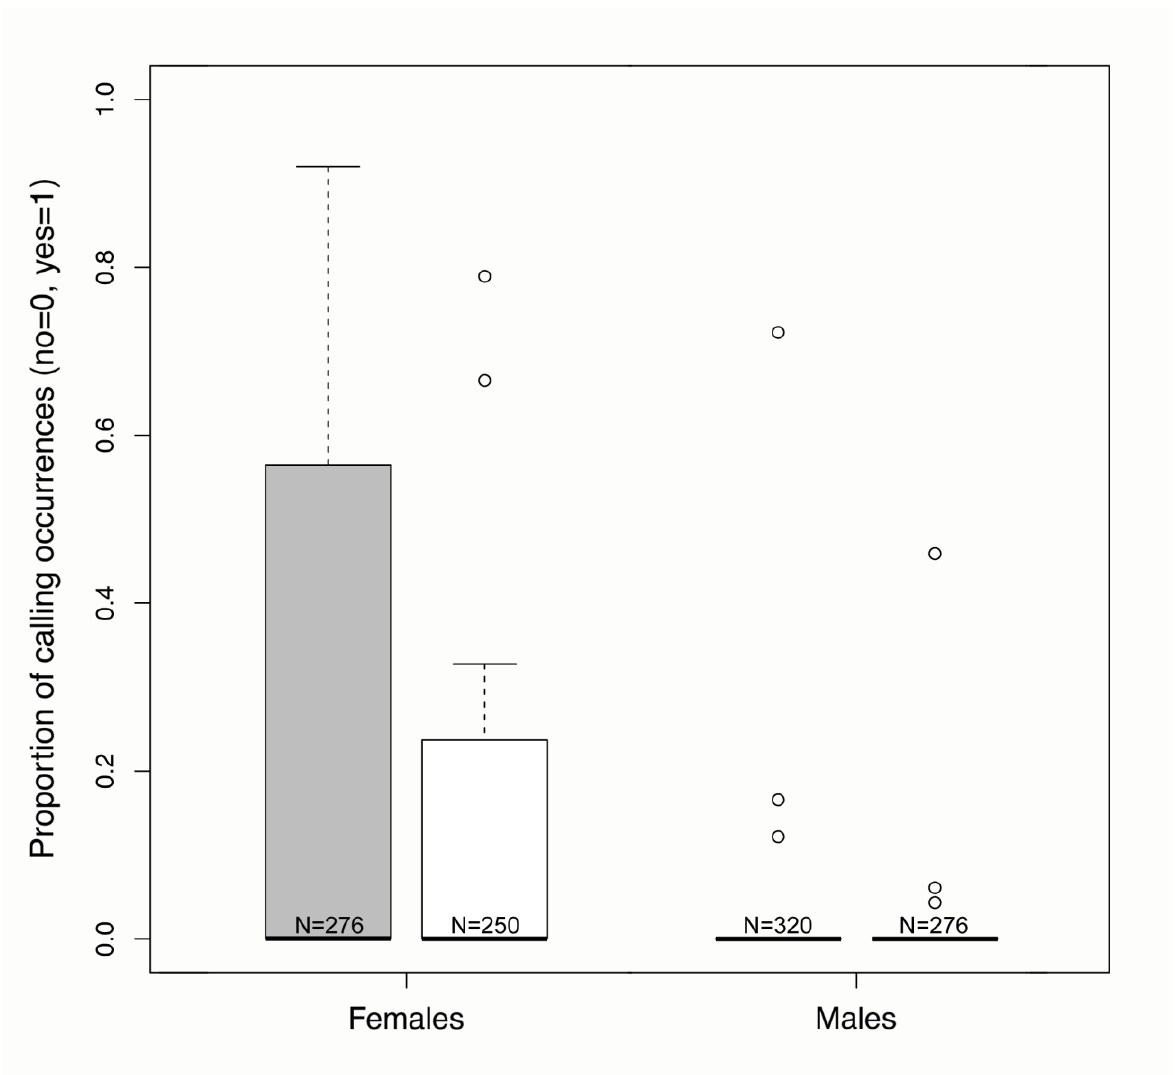
Figure 1 . Proportion of calling occurrences (0 = no calling; 1 = calling) before the first (grey bars) and the second feeding (white bars) for female and male ravens. Values are estimated means derived from the GLMM, and are controlled for fixed and random effects. Whiskers represent the minimum and maximum, bold lines the median of all data, and circles indicate outliers. N denotes the number of cases for each